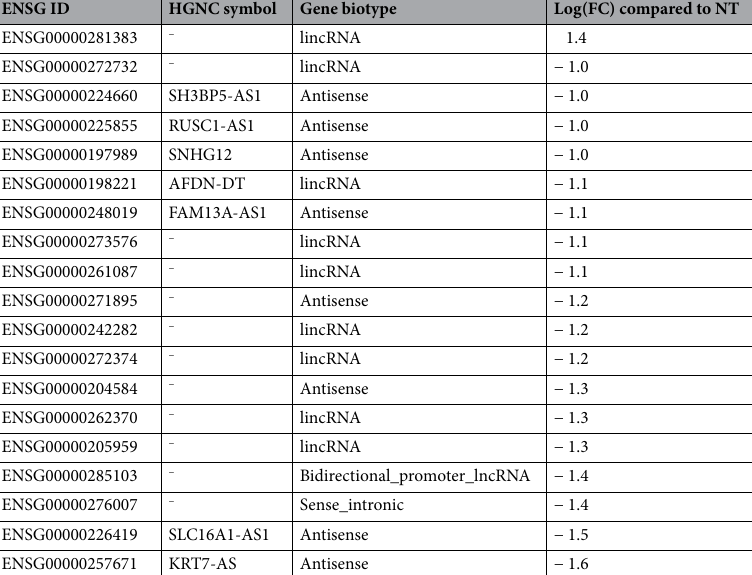
Table 5. LncRNAs specific for FTC. None of these lncRNAs is significantly differentially expressed compared to